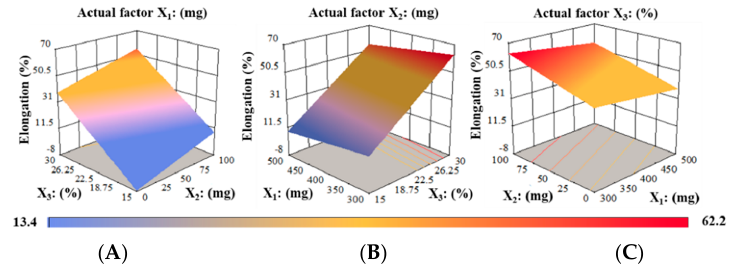
Figure 6. 3D surface models describing the influence of ( A ) PUL (X 1 ), ( B ) MTX (X 2 ), and ( C ) PG (X 3 ) on percent elongation (Y 4 ) of RZT-ODFs.